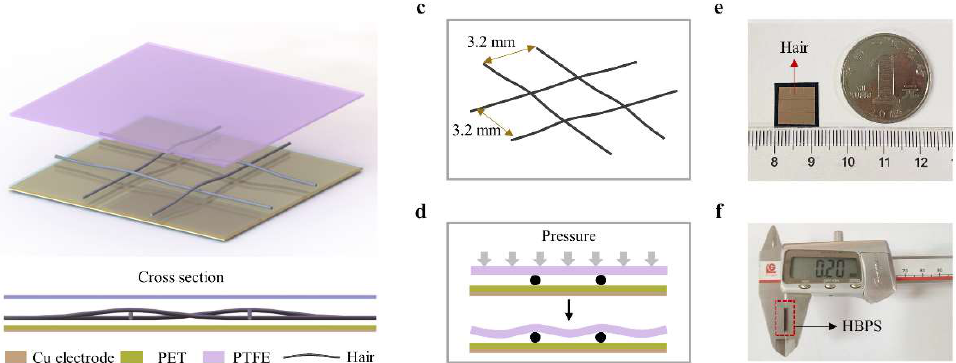
Figure 1. Structure of the designed flexible pressure sensor: ( a ) three-dimensional structure of the proposed hair-based pressure sensor (HBPS), ( b ) A cross section of the HBPS, ( c ) detailed mesh structure formed by lost hair, ( d ) schematic diagram of HBPS deformation under pressure, ( e , f ) optical image of the HBPS with a dimension of 12 × 12 × 0.2 mm 3 .